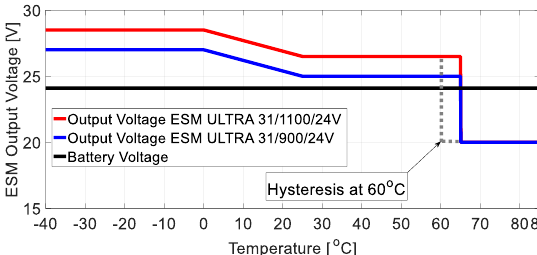
Figure 6. The dependency between the target output voltage between B − and S+ terminals of the ESM module and ambient temperature. Informational material provided by the manufacturer, Maxwell [7].